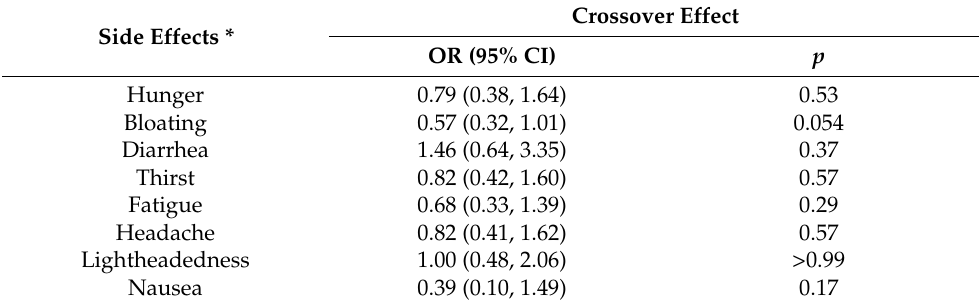
Table 5. Effects of Dietitian-Delivered DASH (DDG) versus Self-Directed Groceries (SDG) on